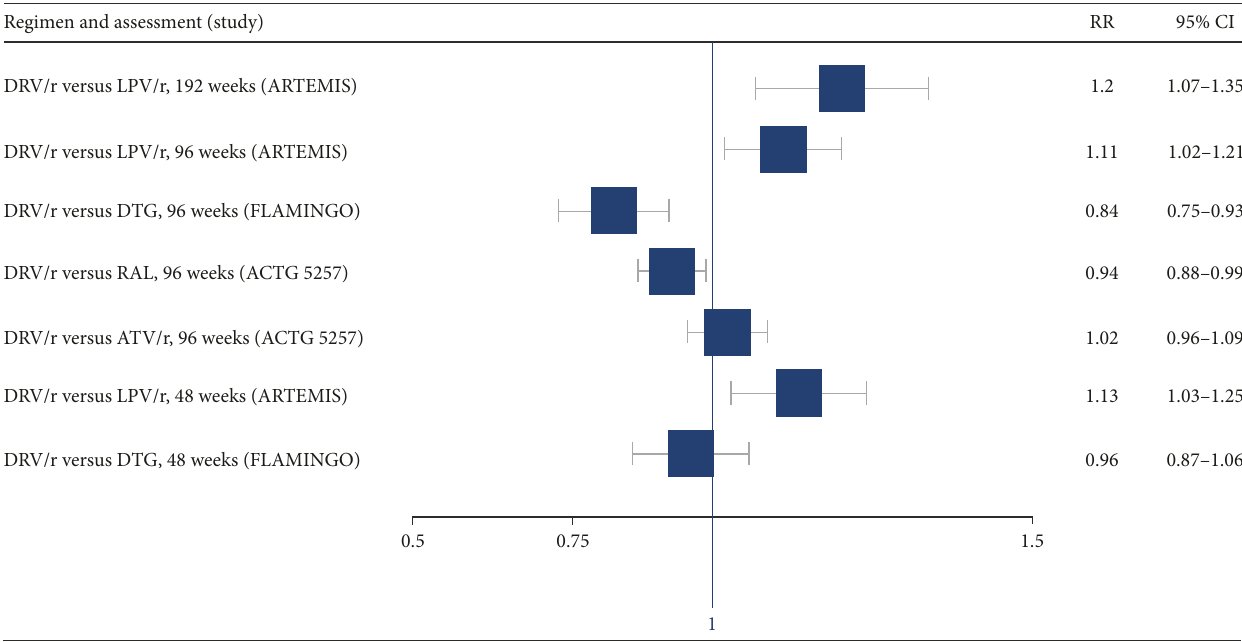
Figure 3: DRV/r-based regimens: efficacy in viral suppression, sorted when outcome was